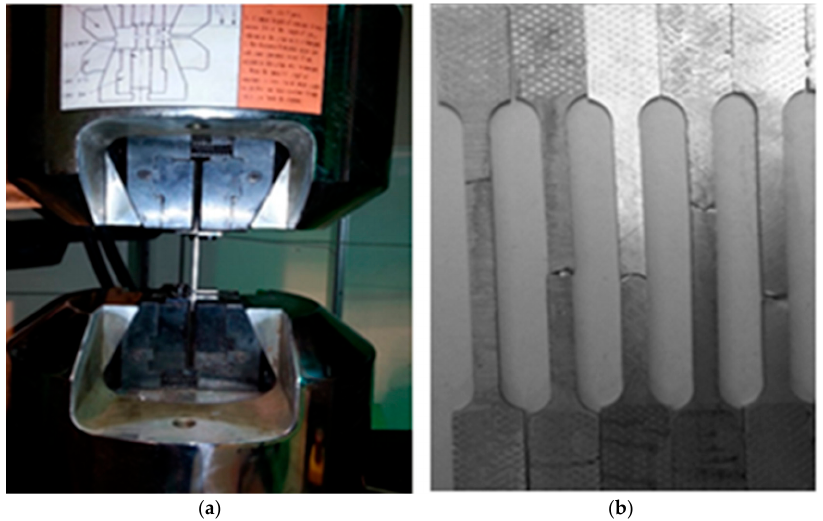
Figure 3. Tension test ( a ) Universal tension test machine; ( b ) samples after the applied tensile test.